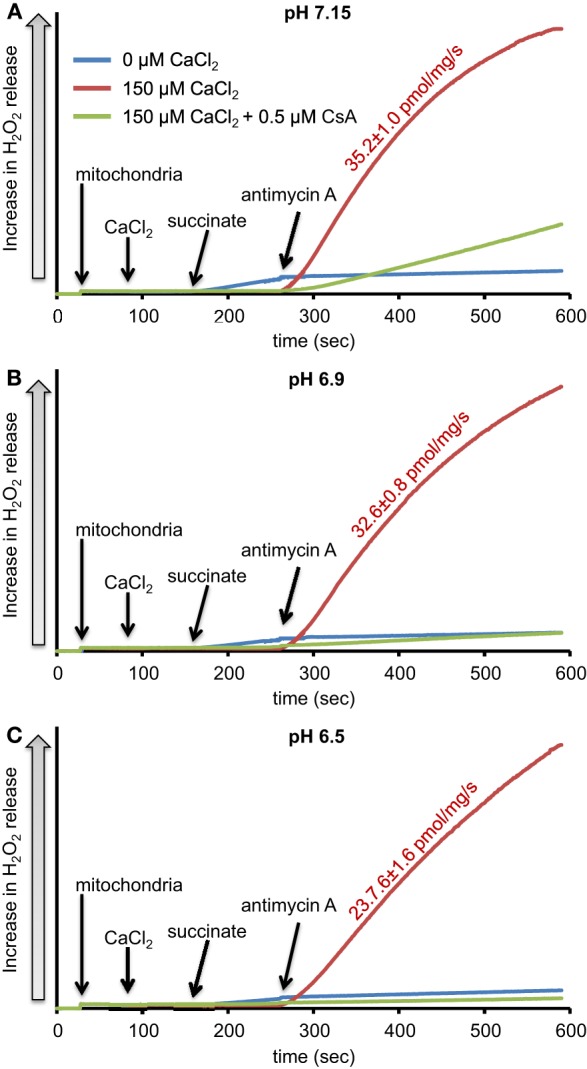
Time-dependent changes in H2O2 release rates in isolated succinate-energized mitochondria after inhibiting complex III with antimycin A (AA) at a different pH: (A) pH 7.15, (B) pH 6.9, (C) pH 6.5. Mitochondria were added to buffer at 30 s, CaCl2 at 90 s, succinate at 150 s, and AA at 270 s. The blue trace represents no added CaCl2, the red trace represents added CaCl2to 150 μM in the presence of 40 μM EGTA (≈ 220 nmol/mg free Ca2+), and the green trace represents added CaCl2to 150 μM with CsA. Numbers indicate mean values ± SEM of pmol H2O2generated/mg/s. N = 4 each.